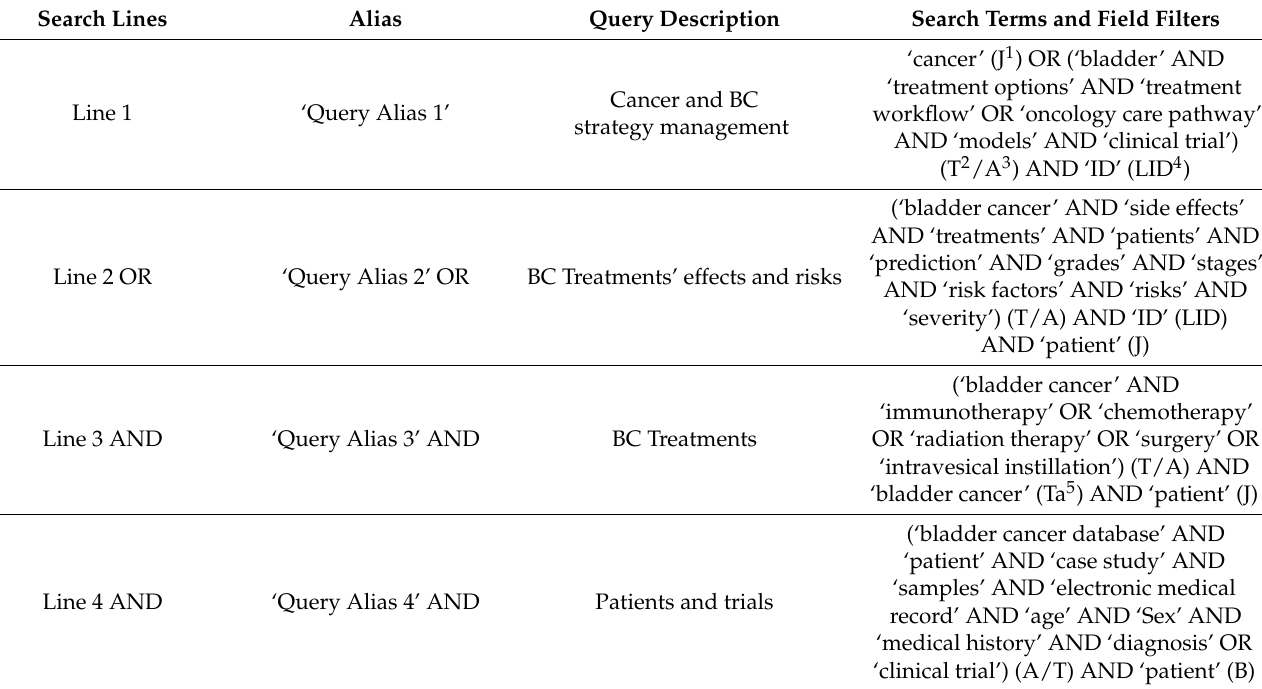
Table 1. Search criteria and selection of BC treatments risks and effects crawling variables. Search